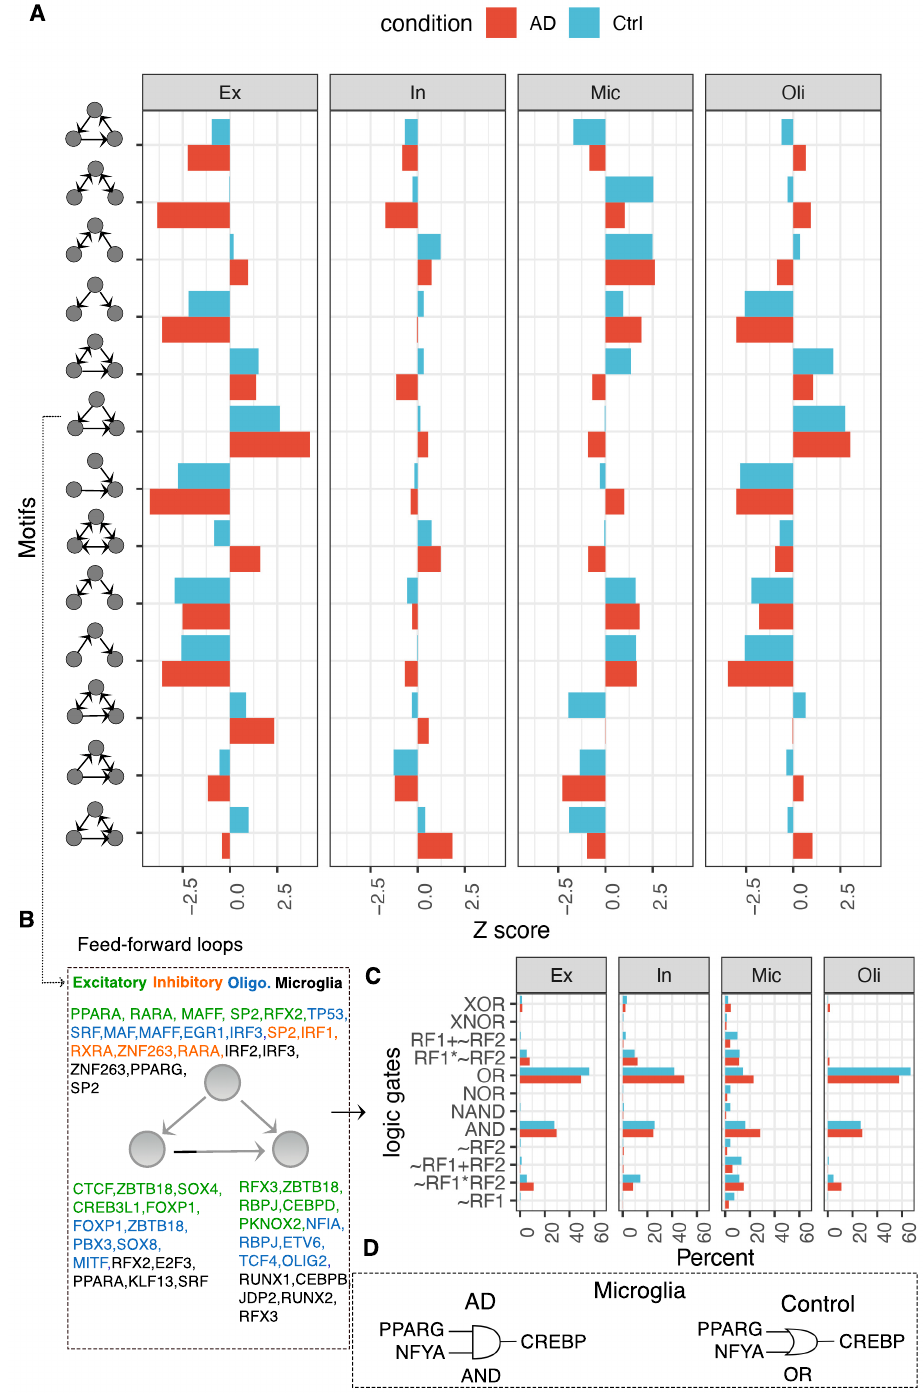
Fig 4. Network motifs and regulatory logic across cell types in AD. ( A ) Barplots showing the enrichment (x-axis; Z- score estimates from random networks) of various three-node triplets (y-axis) in AD (red) and control (blue) conditions across all four cell types. ( B ) Genes that frequently occur in feed-forward loops in cell type AD GRNs are depicted and colored uniquely for each cell type. ( C ) Barplot showing the frequency (x-axis) of various logic gates (y- axis) active within the feed-forward loops in AD (red) and control (blue) conditions across all four cell type networks. ( D ) Logic gate diagram showing PPARG-NFYA-CREBP triplet’s AND logic in AD and OR logic in control networks of